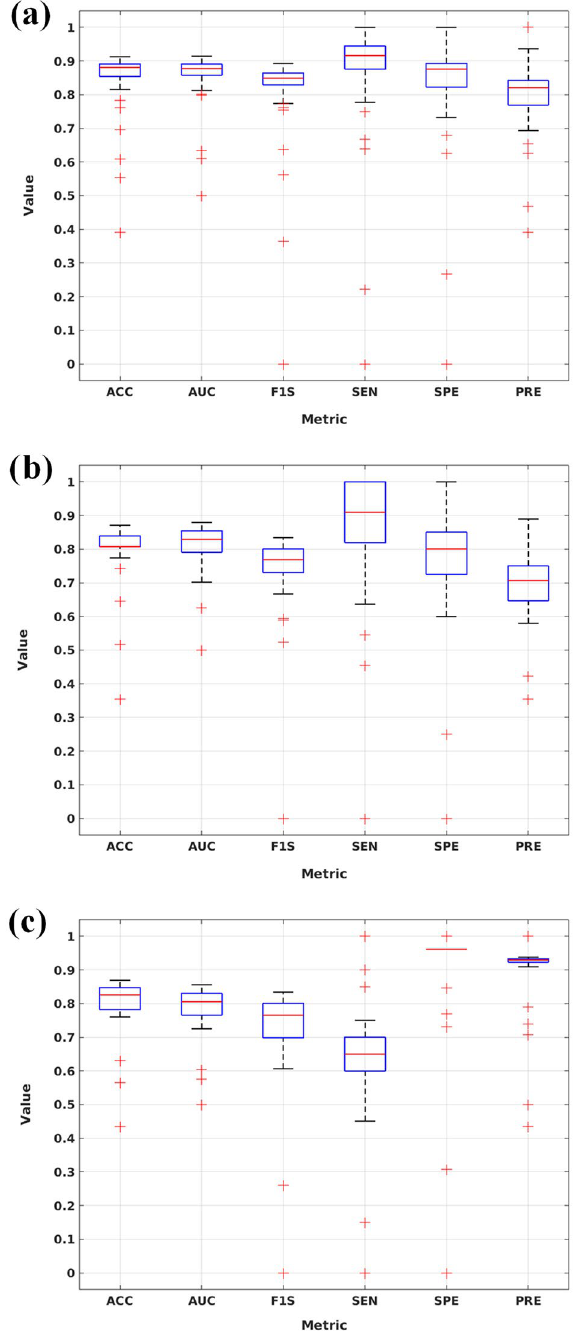
Figure 4. CNN classification accuracy with ( a ) training ( b ) validation and ( c ) test data. ACC = accuracy, AUC = area under the receiver operating characteristic curve, F1S = F1 score, SEN = sensitivity, SPE = specificity, PRE = precision.